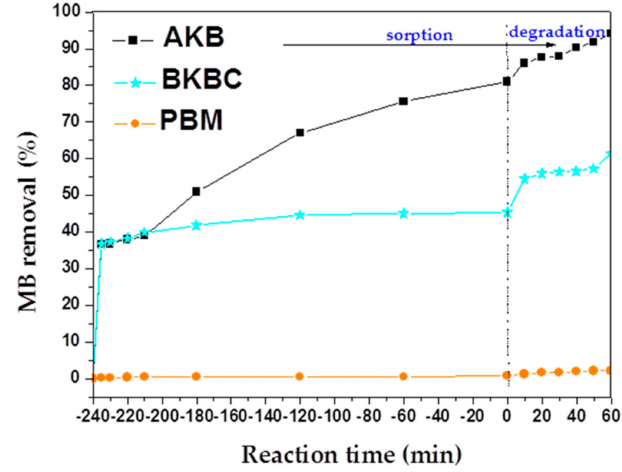
Figure 11. Adsorption and photodegradation progress of MB (80 mg/L) by AKB, BKBC, and PBM as a function of time. The photocatalytic degradation was initiated after sorption for 4